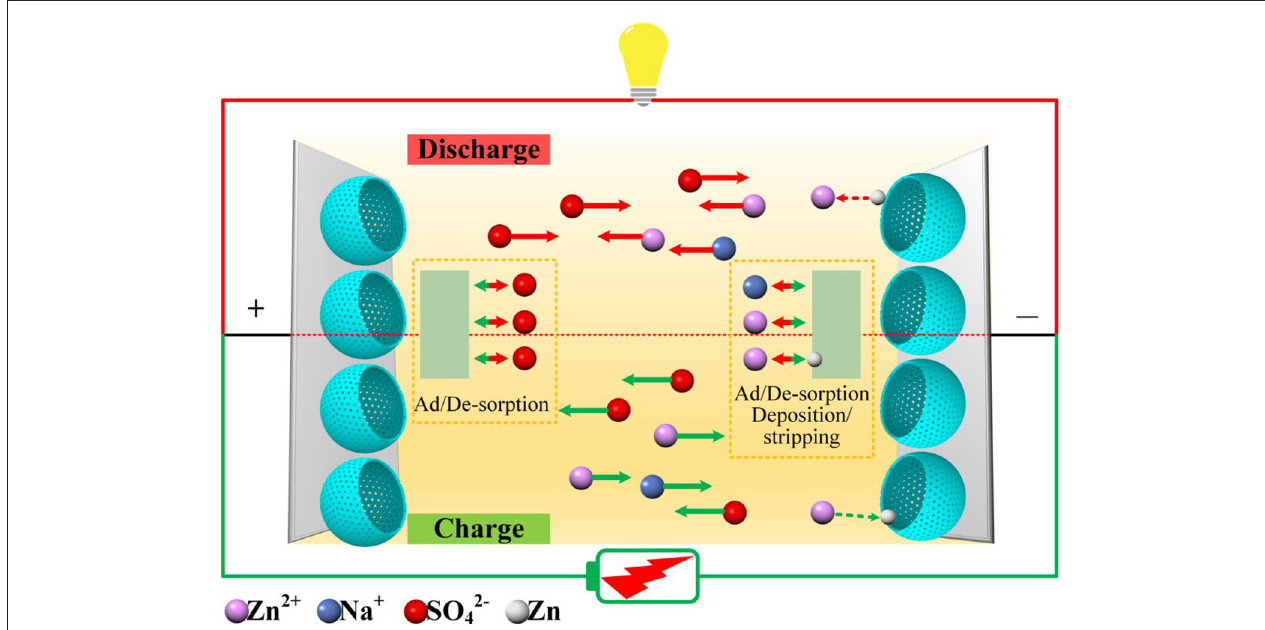
FIGURE 5 | Schematic illustration of the as-proposed device and its working